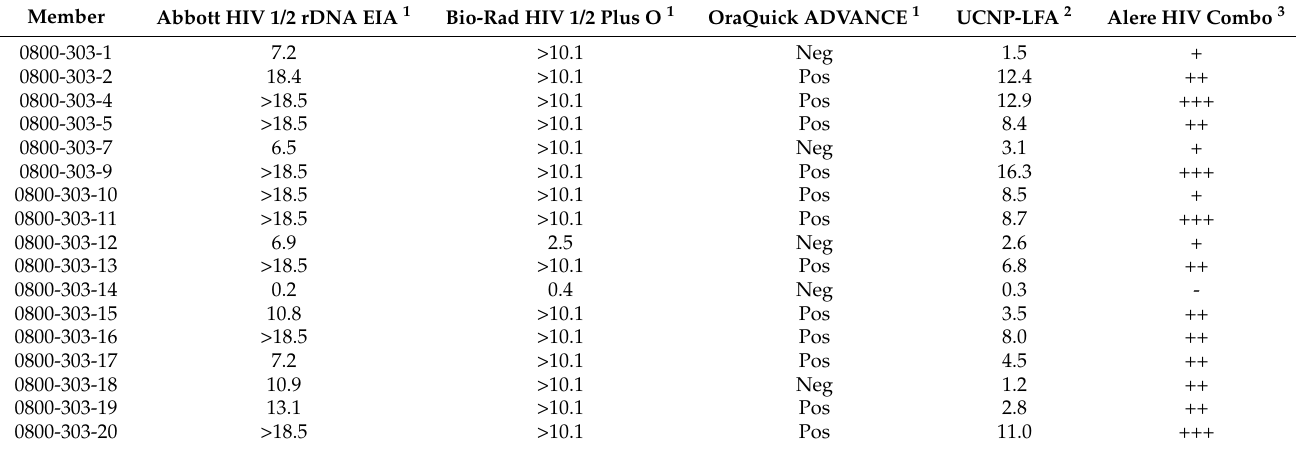
Table 5. Anti-HIV-1 Mixed Titer Panel (0800-0303) (PRB205).